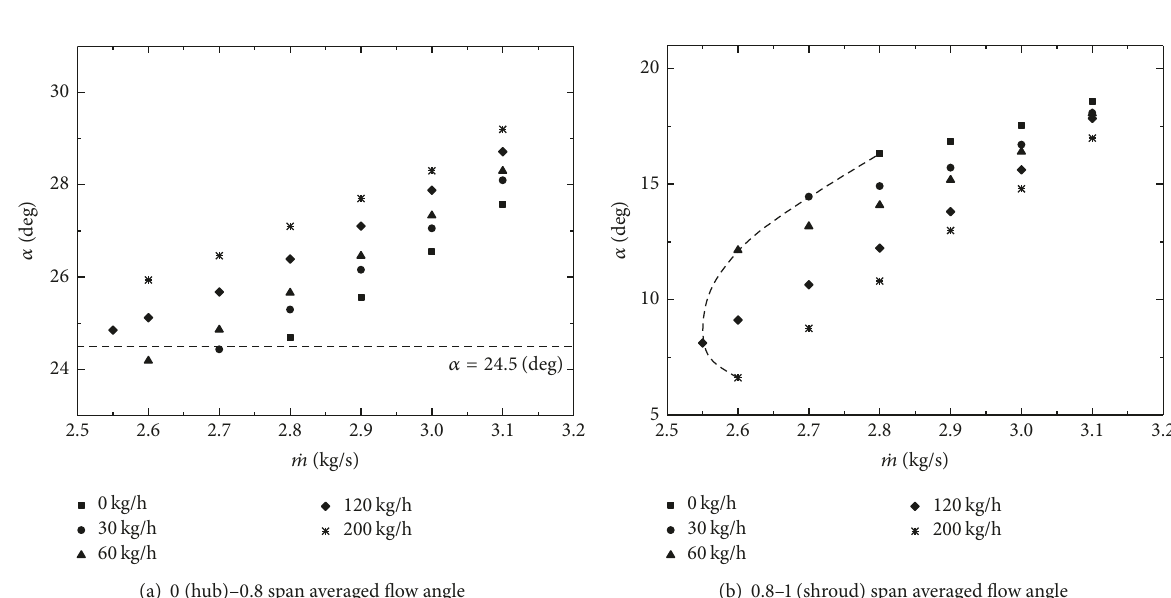
Figure 17: Flow angle at diffuser inlet of different span